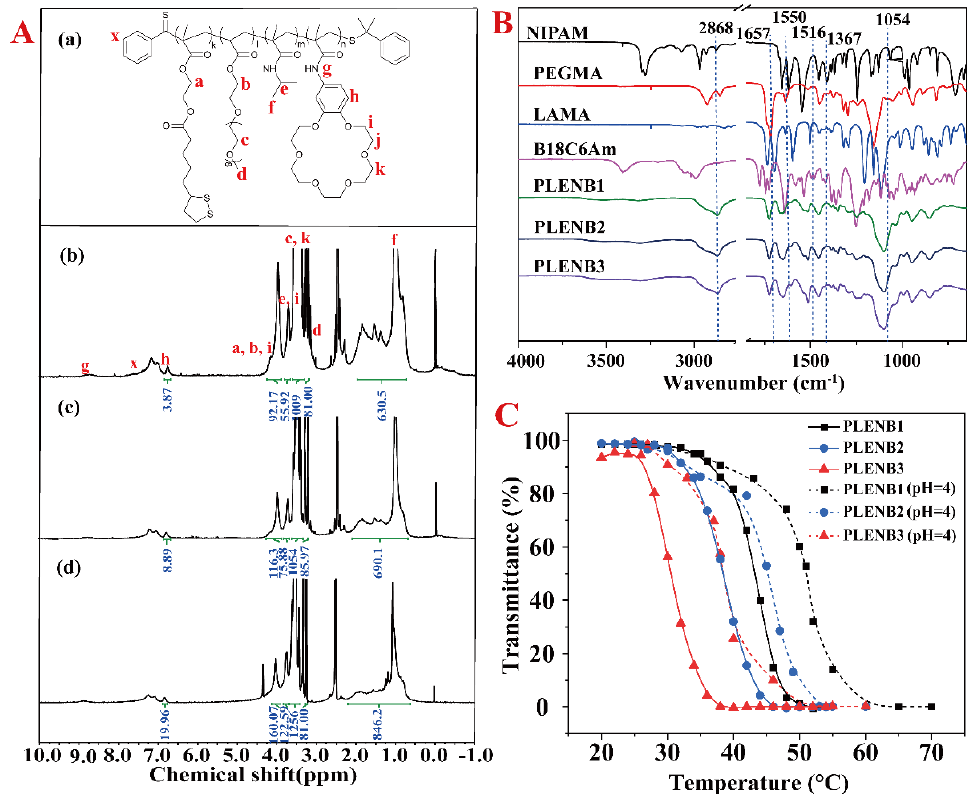
Figure 2. The 1 H NMR spectra ( A ) (( a ): the structure of PLENB; 1 H NMR spectra of PLENB1 ( b ), PLENB2 ( c ) and PLENB3 ( d )) and FTIR spectra ( B ) of PLENB polymer; and the LCST of PLENB polymer in both neutral and acidic environments by UV − vis spectroscopy ( C ).